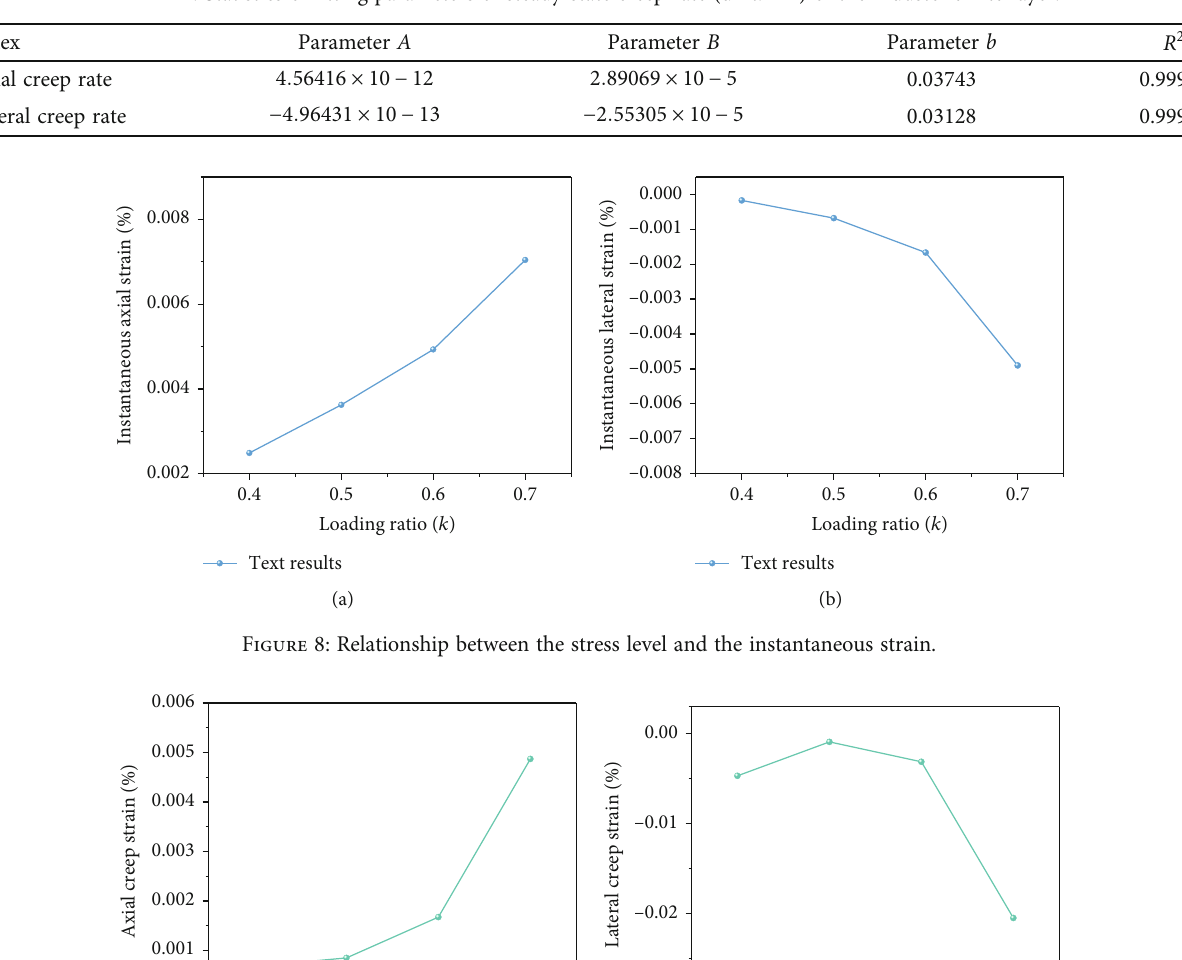
Table 2: Statistics of fi tting parameters of steady-state creep rate (unit: h − 1 ) of the mudstone interlayer.